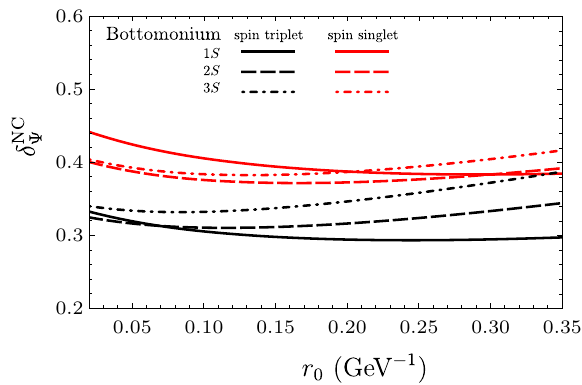
Figure 6 . The non-Coulombic corrections δ NC 2 S (dashed lines), and 3 S (dot-dashed lines) states, for spin triplet (black) and spin singlet (red). The r dependences are mild for the range 0.05 GeV − 1 < r 0